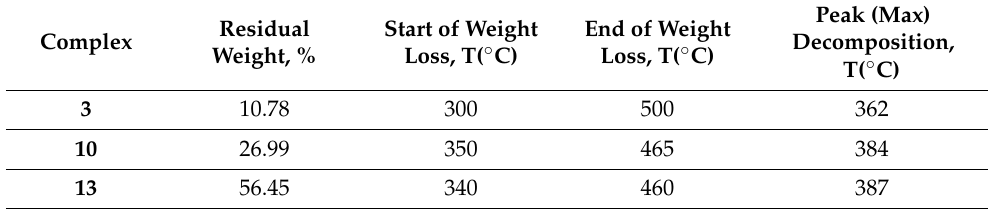
Table 1. Thermogravimetric data for complexes 3 , 10 and 13 .